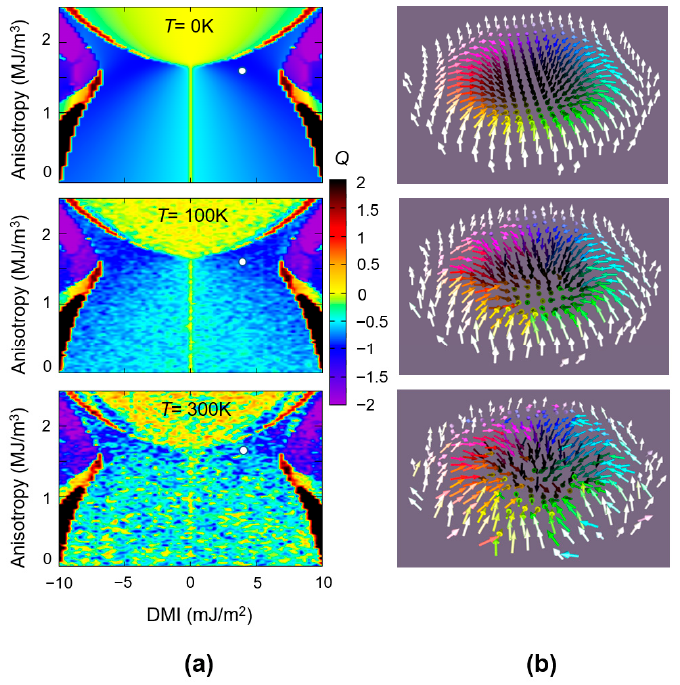
Figure A1. ( a ) DMI - PMA - Q phase diagrams calculated at different temperatures 0 K, 100 K, 300 K. ( b ) Magnetization vector field representation of skyrmionic structures corresponding to the point ( DMI = 5 mJ/m 2 , K u = 1.7 × 10 +6 J/m 3 ) indicated with a white filled circle in the diagrams of the panel ( a ). The calculation has been performed for a 90 nm disk with the following fixed parameters: M s = 1714 kA/m, A ex = 2.1 × 10 +11 J/m; the Gilbert damping constant α = 0.01.